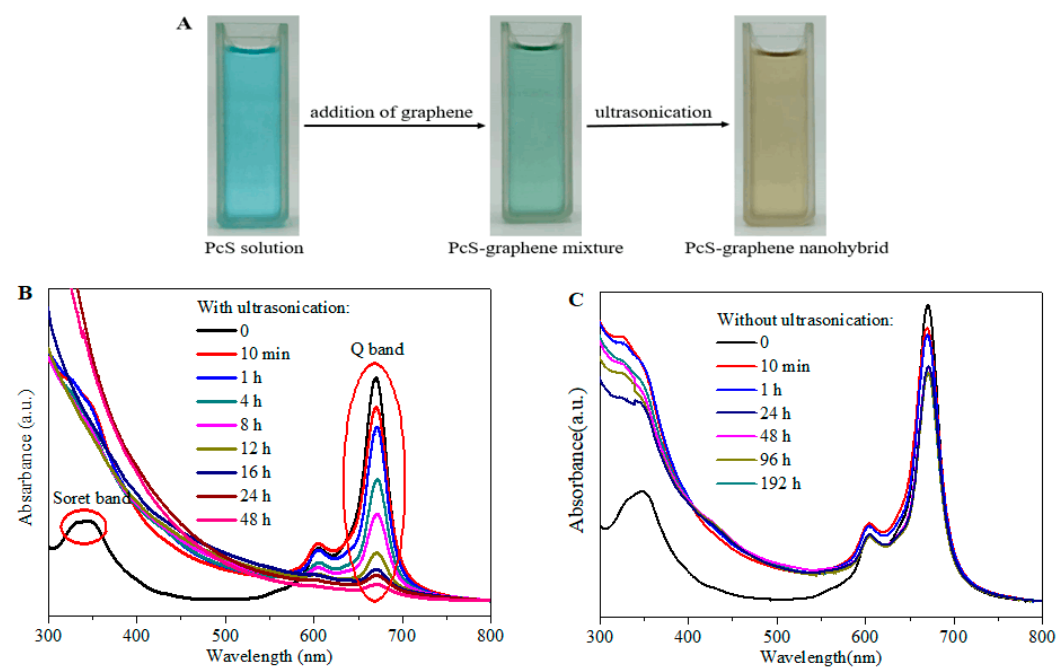
Figure 3. ( A ) Color changes of sulfonated cobalt phthalocyanine (PcS) solution with the addition of graphene and the ultrasonic treatment; ( B ) Effect of ultrasonic time on the UV-vis absorption spectrum of the PcS–graphene nanohybrid; ( C ) Effect of time on the UV-vis absorption spectrum of the PcS–graphene mixture.